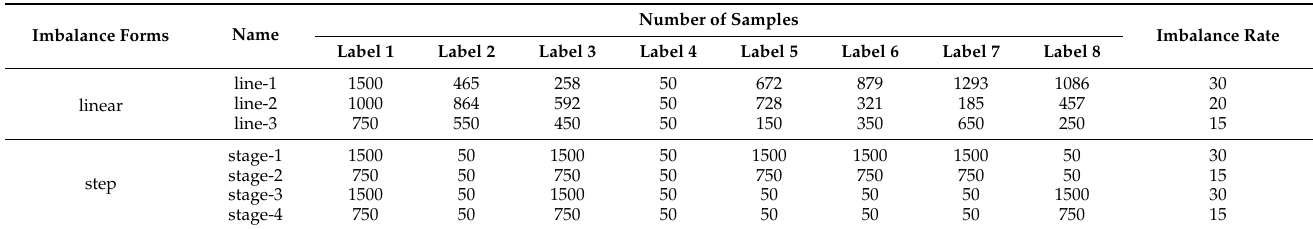
Table 5. Unbalanced data sets